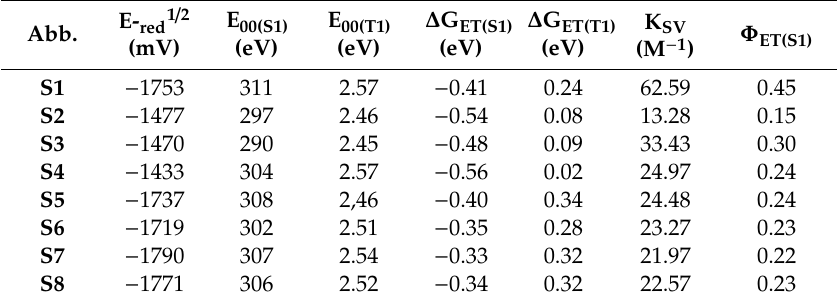
Table 4. Electrochemical and thermodynamically properties of investigated in the presence of different photoinitiating systems based on EDB (1.5% w / w ) and 2-amino-4-methyl-6-phenyl-benzene-1,3-dicarbonitrile derivatives (0.1% w / w ) in terms of their use in photo-reduction mechanism in light induces electron transfer process.